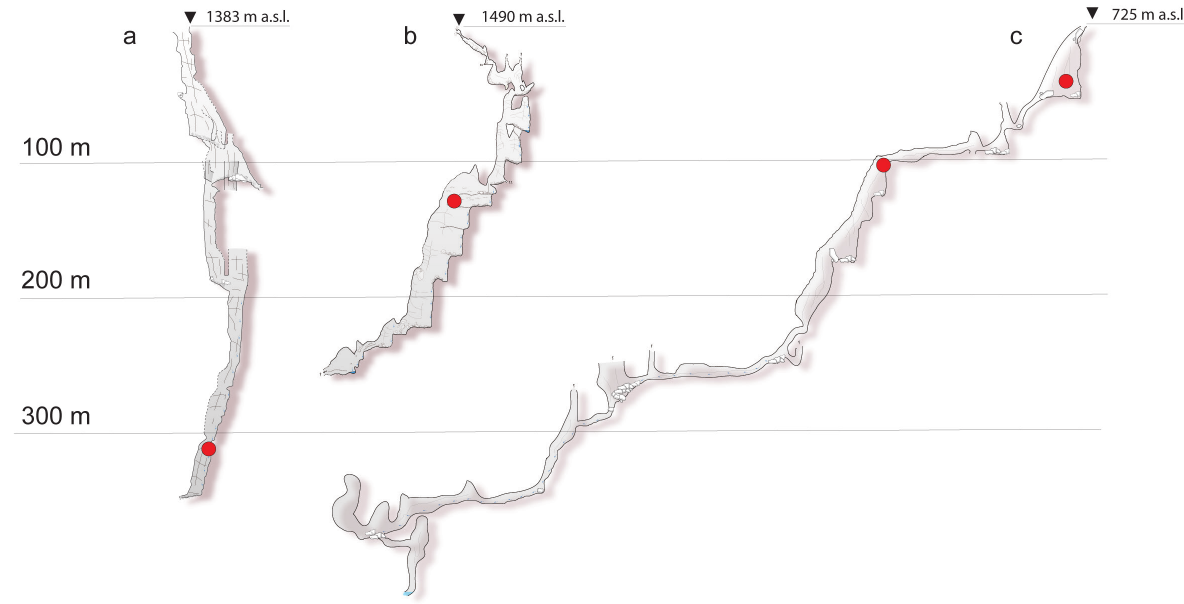
Figure 1. Cross sections of the caves from which the newly described species were collected: a) Biokovka, Golubinjak, Mt Bioko- vo, Croatia; b) Pretnerova jama, Lokva, Mt Biokovo, Croatia; c) Pištet 4 cave (PT4), Velji Pištet, Kameno more, Risan, Montenegro. Approximate finding localities are presented with red points. The original cave surveys of Biokovka and PT4 were made by Ivan Glavaš and the University of Bristol Spelaeological Society,